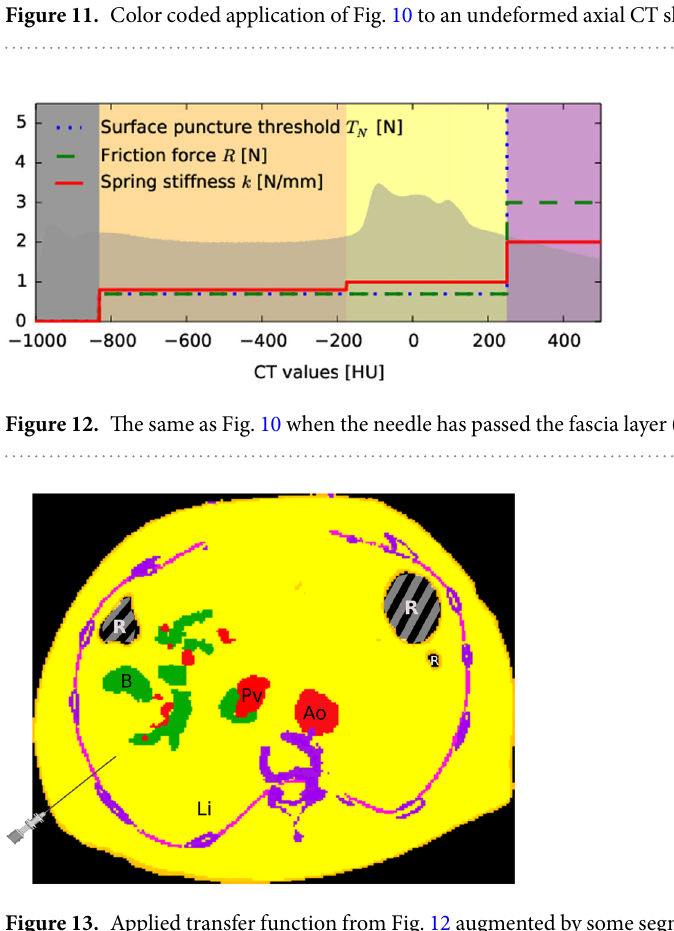
(outside fascia) and an augmented + t x ( )